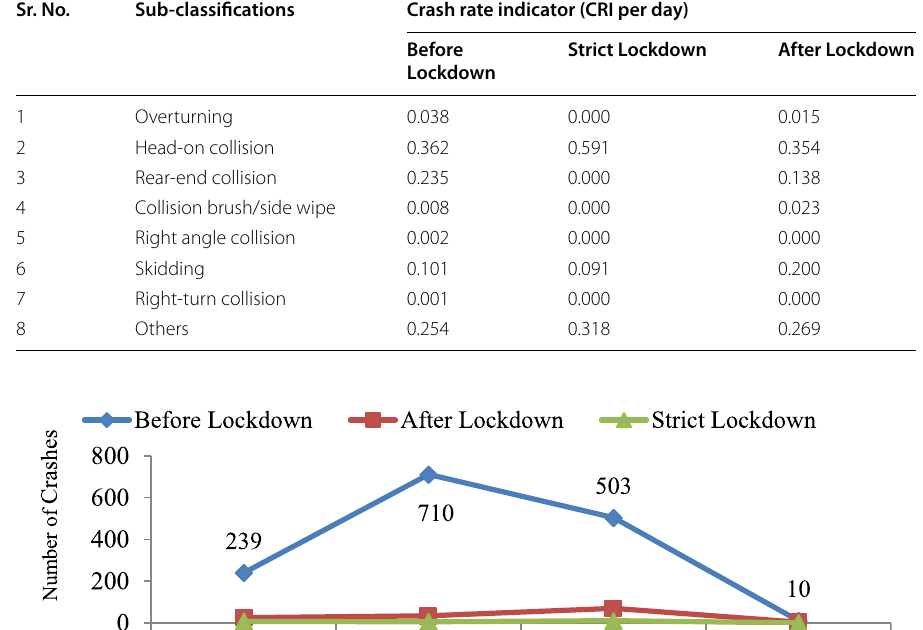
Table 3 CRI by nature of crash Sr. No.